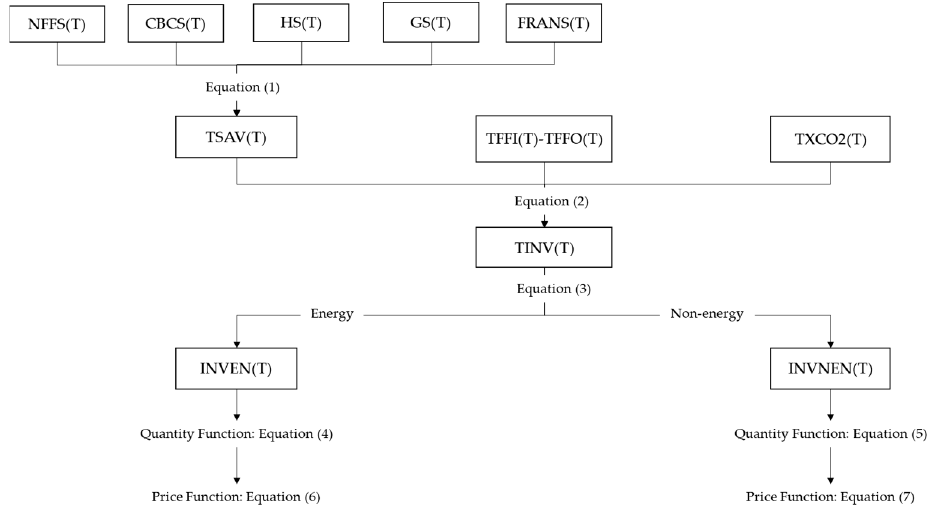
Figure 4. Equation’s framework and variables link in investment